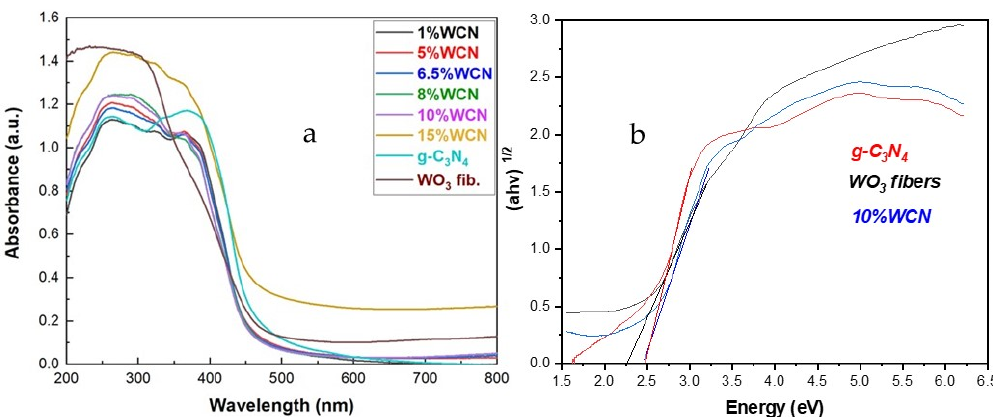
Figure 5. ( a ) UV-vis absorption spectra of prepared catalysts, ( b ) Kübelka-Munk plots for WO 3 fibers, g-C 3 N 4 and 10%WCN materials. for indirect band gap semiconductors.